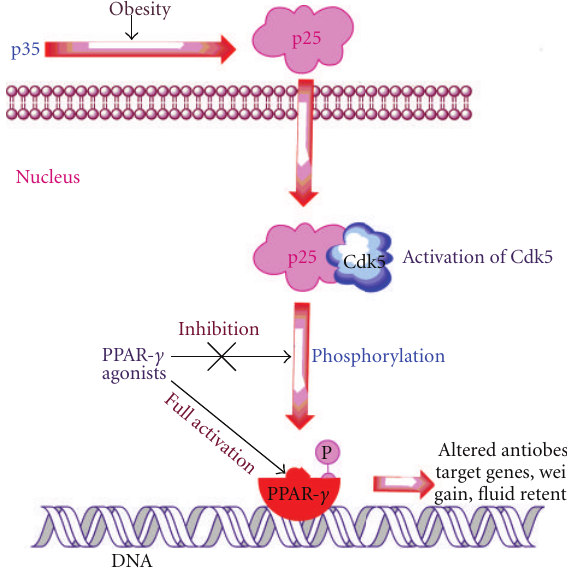
Figure 3: Choi et al . [1] show that PPAR γ activity is controlled by the CDK5. Obesity leads to the various signals that cause the cleavage of p35 to p25 which will then translocates to the nucleus and forms a bond with CDK5 and activates it. CDK5 phosphorylates the PPAR γ receptor on serine residue 273 averts the transcription of antiobesity e ff ects, while the full activation of PPAR γ by PPAR γ agonists may probably responsible for the weight gain and Fluid